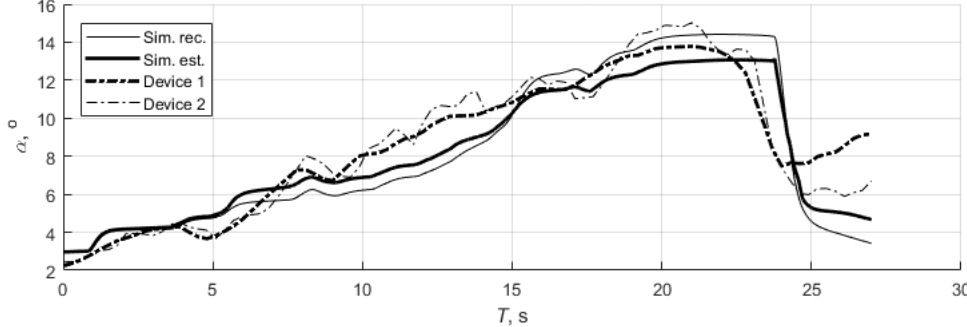
Figure 9. The AoA in the test flight and flight simulator in the stall with idle power